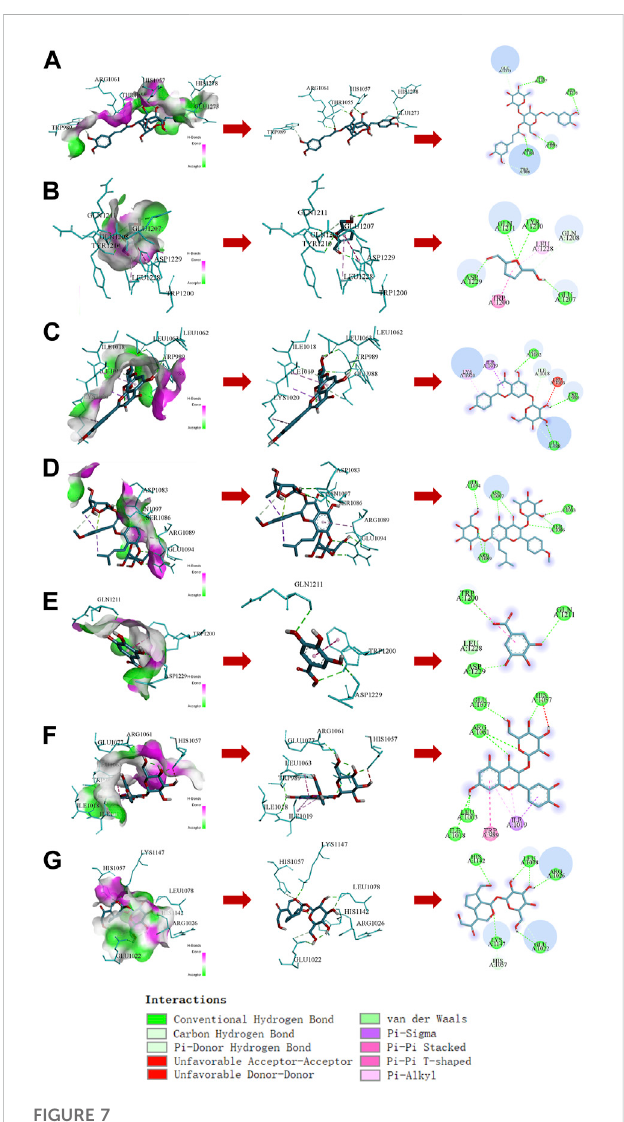
FIGURE 7 Docking analysis of compounds in RRP with INSR protein. (A – G) : Acteoside, 5-HMF, Apigenin7-O-glucuronide, Icariin, Gallic acid, Quercetin-3 β -D-glucoside,